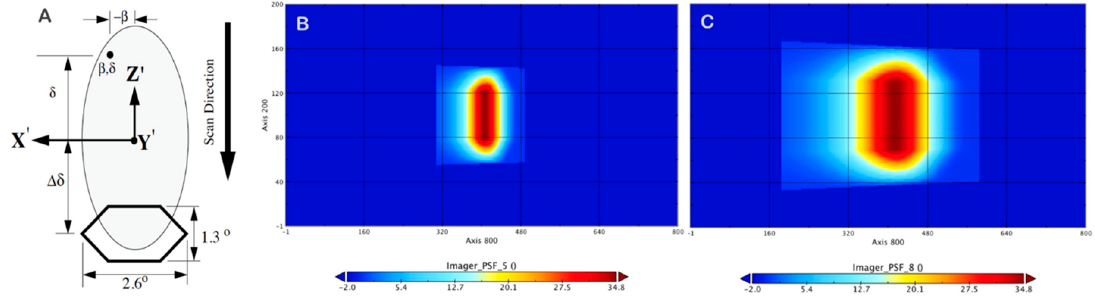
Figure 3. ( A ) Illustration of the CERES Point Spread Function from the ATBD; ( B ) and ( C ) Simulated CERES PSF for scan angle 29° and 48°, respectively. The edges of PSF are shown in light blue. Footprint size in along-scan direction changes from 90 km to 200 km.